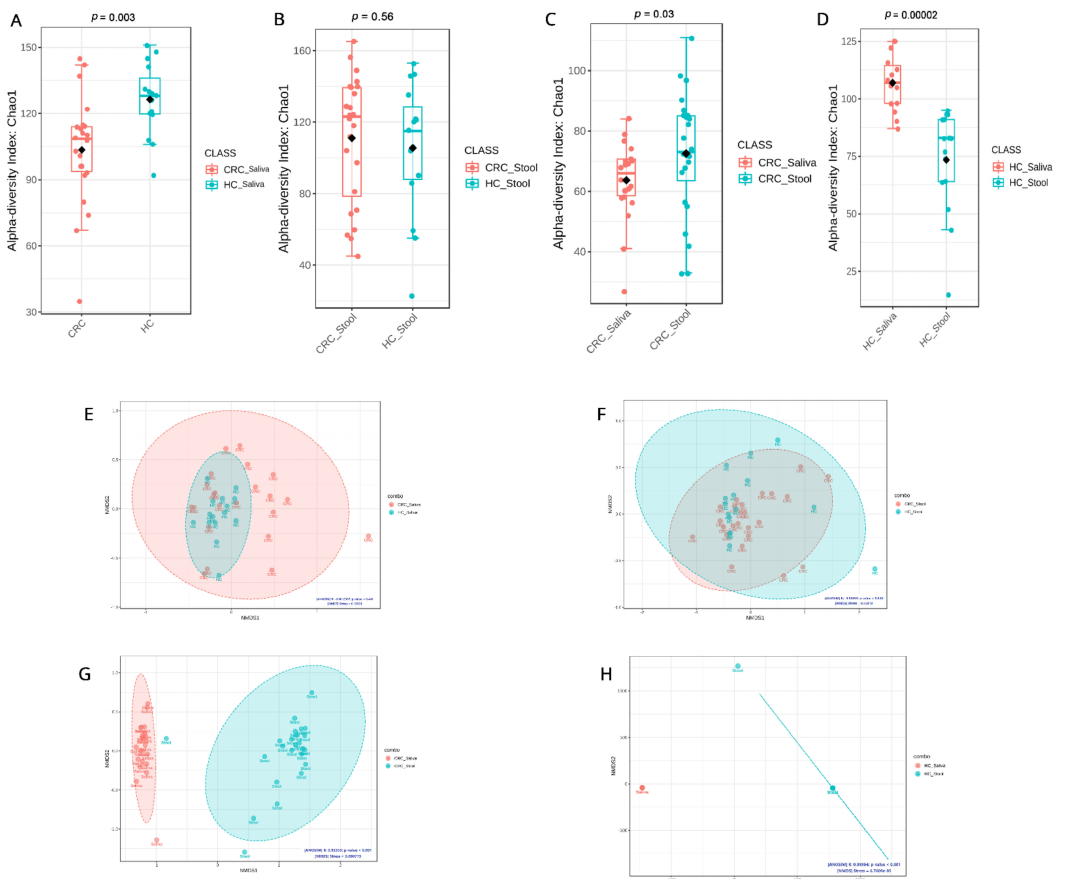
Figure 2. Microbial community diversity across our study groups using the Chao1 approach for α -diversity and NMDS metric for β -diversity: ( A ) α -diversity of saliva samples from CRC patients and healthy controls; ( B ) α -diversity of stool samples from CRC patients and healthy controls; ( C ) α - diversity of saliva and stool samples from CRC patients; ( D ) α -diversity using CHAO1 of saliva and stool samples from healthy controls; ( E ) β -diversity of saliva samples from CRC patients and healthy controls; ( F ) β -diversity of stool samples from CRC patients and healthy controls; ( G ) β -diversity of saliva and stool samples from CRC patients; ( H ) β -diversity of saliva and stool samples from healthy